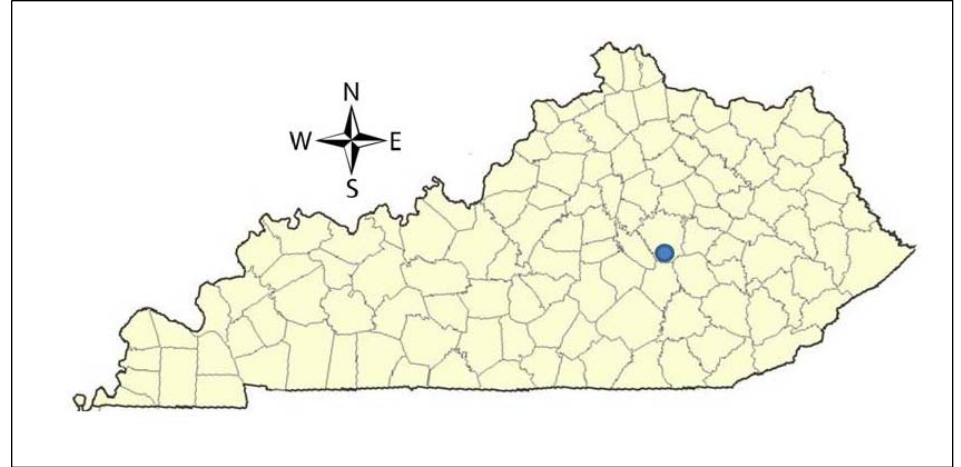
Figure 1. Location of the Berea College and its Student Farm The Berea College Farm is in Berea, Kentucky, in a region known as the Knobs, between the Bluegrass and the Appalachian foothills (also known as the Eastern Kentucky Coal